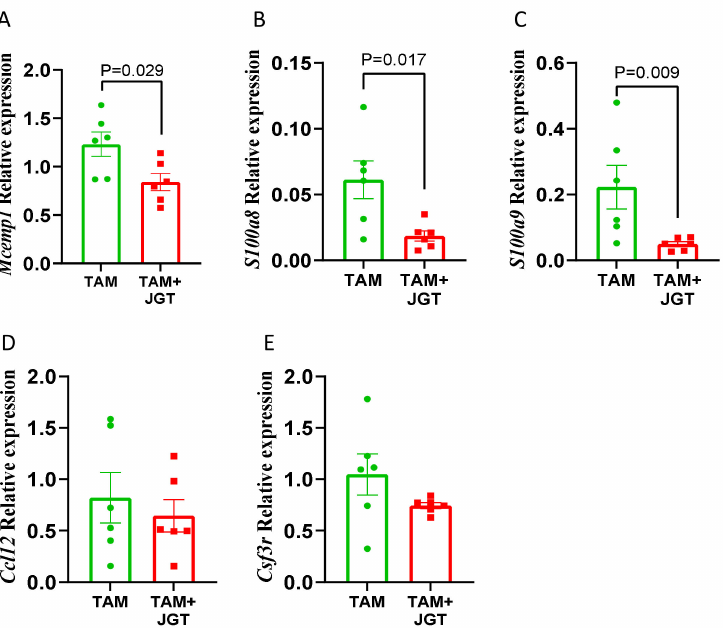
Figure 7. Effect of Jaeumganghwa-tang (JGT) on gene expression in the mammary glands of group- housed (GH) rats during tamoxifen therapy. Expression of ( A ) Mcemp1, ( B ) S100a8, ( C ) S100a9, ( D ) Ccl12, and ( E ) Csf3r in the mammary glands of GH rats during tamoxifen (TAM) therapy, which were either treated or not treated with JGT. JGT significantly decreased the expression of Mcemp1, S100a8, and S100a9. Differences according to the t test. Means ± SEM, n = 6 per group are shown. Green circles = Tamoxifen treated rats; red squares = tamoxifen + JGT treated